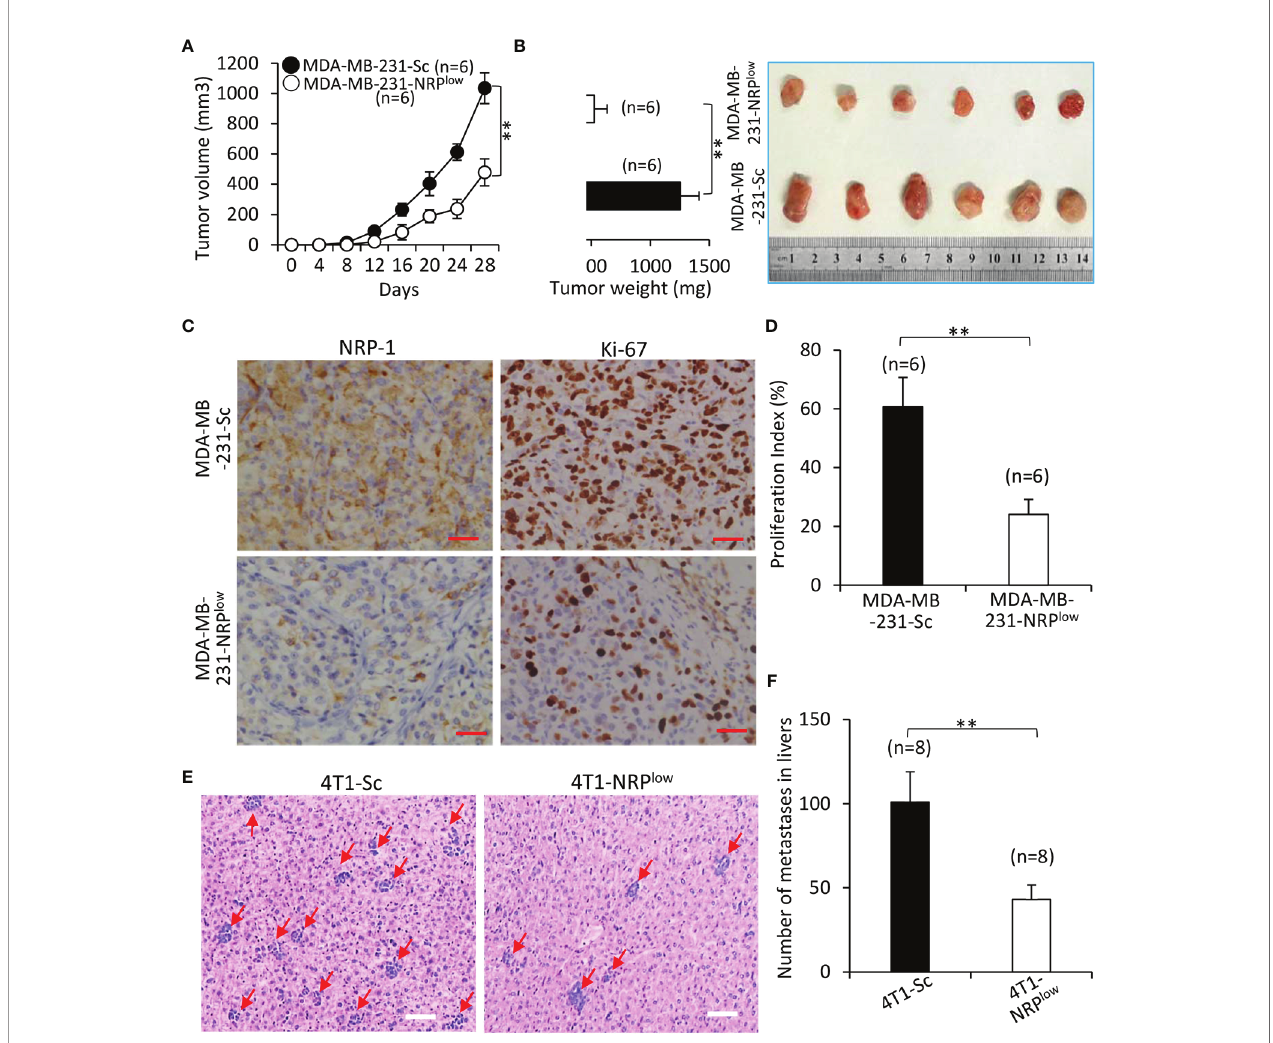
FIGURE 7 | Depletion of NRP-1 inhibits the growth and liver metastasis of TNBC tumors in mice. (A, B) MDA-MB-231-Sc and MDA-MB-231-NRP low cells were subcutaneously inoculated into two groups of BALB/c-nu/nu mice. (A) The size of tumors was measured at indicated time points. (B) Tumors were resected from mice, weighed and photographed 28 days after cell inoculation. (C) Illustrated are representative images from tumor sections, which were immunostained with anti-NRP-1 and anti-Ki-67 Abs. Magni fi cation bar = 100 µm. (D) The cell proliferation index was quanti fi ed. (E, F) 4T1-Sc and 4T1-NRP low cells were injected into the left inguinal mammary fat pad of BALB/c mice. Livers were taken 35 days later, stained with HE, examined under microscopy (E) and numbers of metastatic nodules were counted (F) . Magni fi cation bar = 500 µm. Metastatic nodules in livers are pointed by arrows. “ n ” indicates the number of mice in each group. “ **P < 0.001 ”